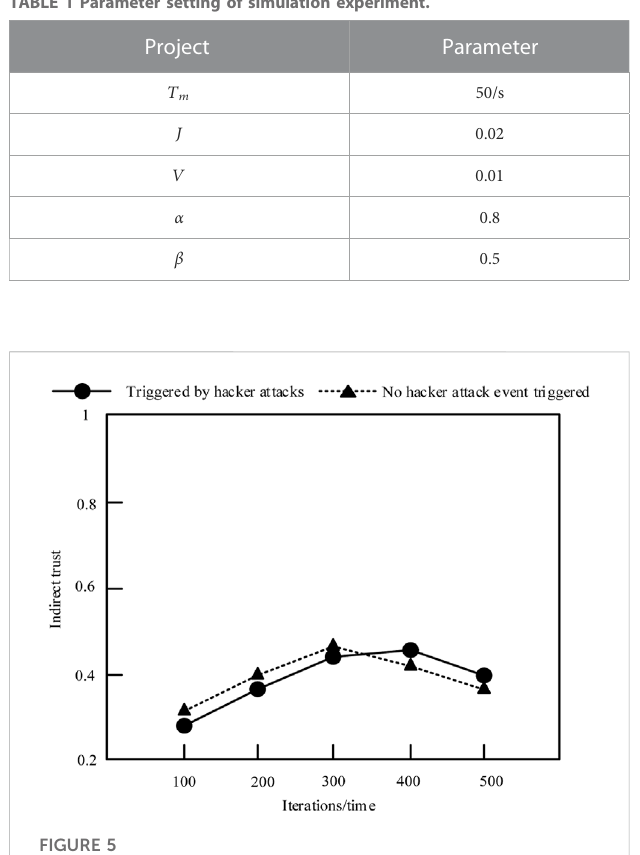
FIGURE 5 Impact of hacker attacks on power network node trust.